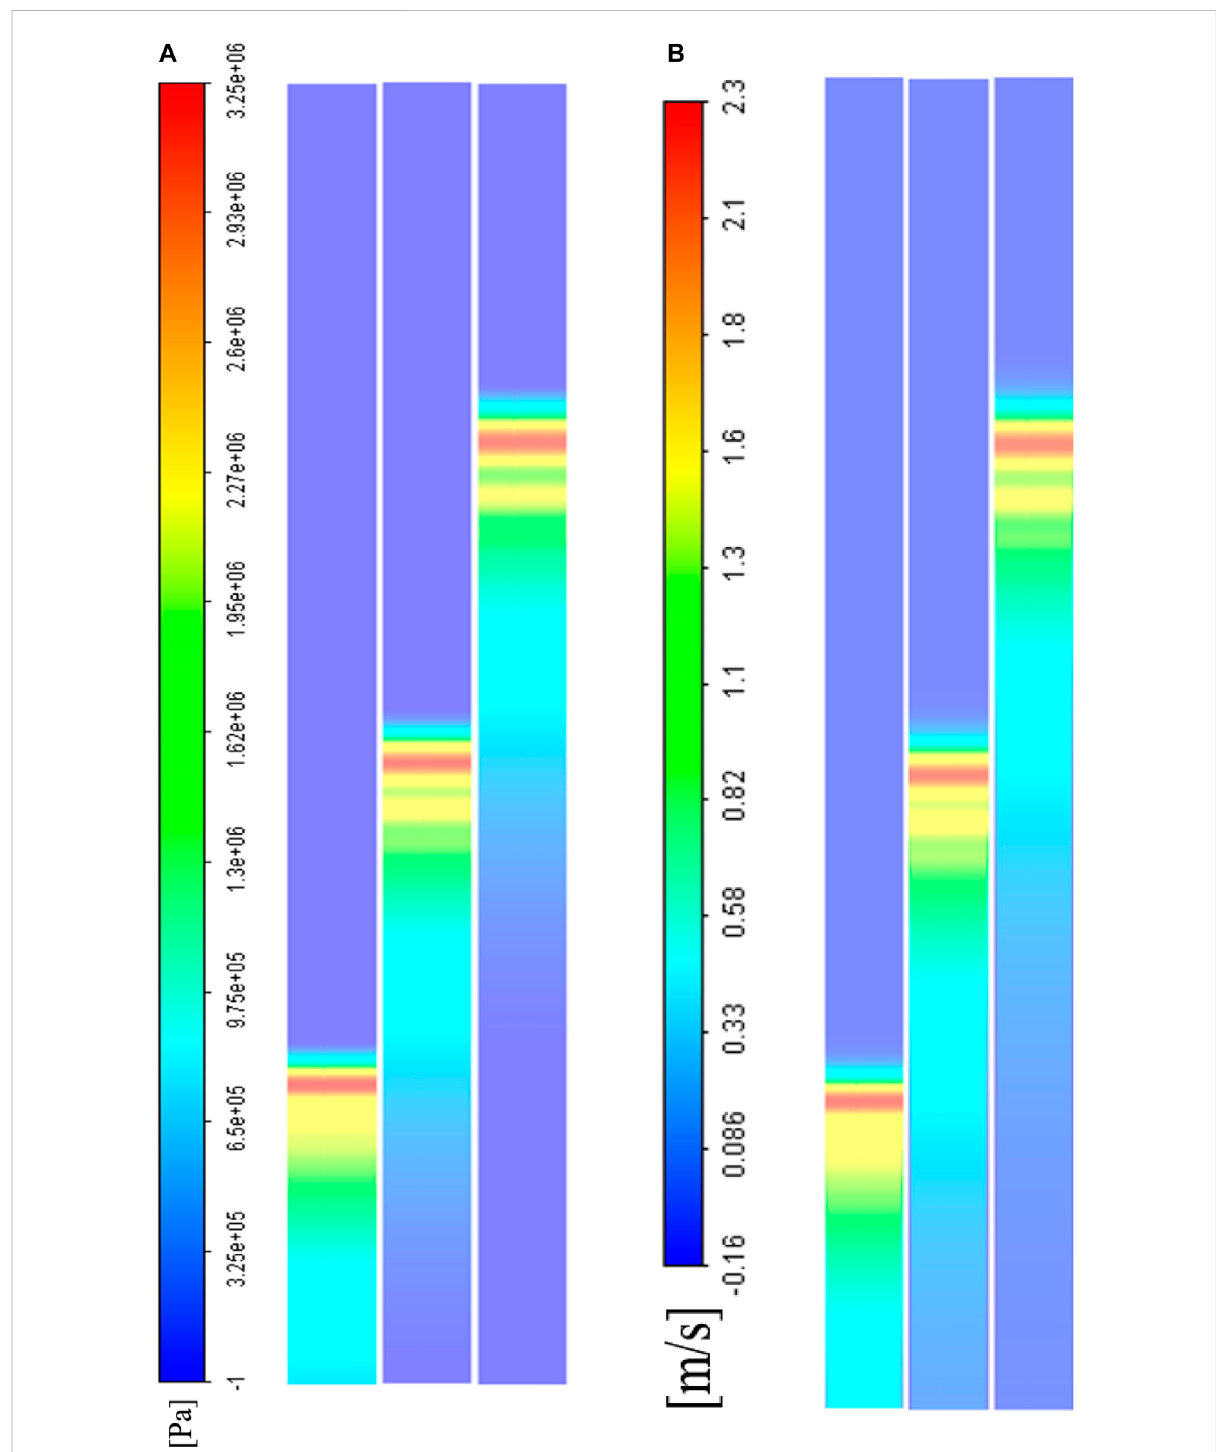
FIGURE 5 A CFD visualization of weak shock wave propagation in the middle axial cross-section at different time steps ( t 1 (cid:2) 0 . 25 T , t 2 (cid:2) 0 . 50 T , t 3 (cid:2) 0 . 75 T ). (A) The total pressure fi eld; (B) The axial velocity fi